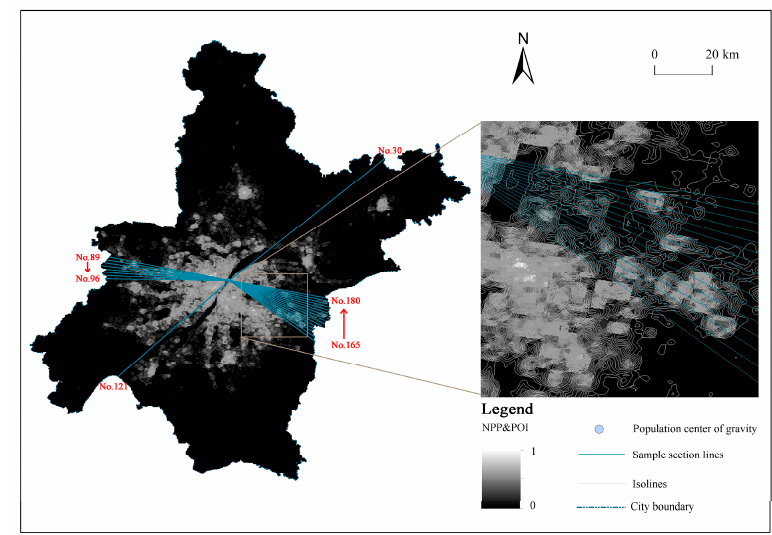
Figure 3. Schematic diagram of NPP and POI section lines and isolines.